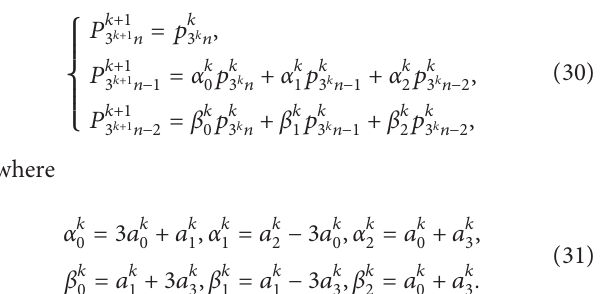
Figure 7: Limit curve by our scheme when lim initial polygon derives from f ( x ) � cosh ( x )